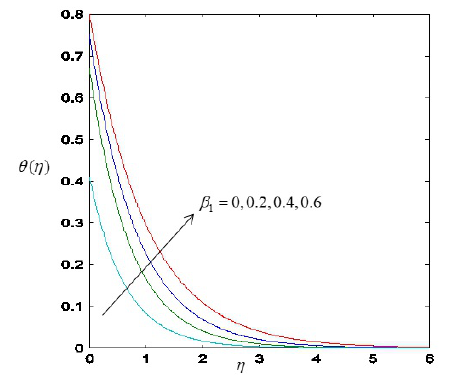
Fig. 7: Influence of Deborah number in terms of relaxation time β 1 on θ ( η )